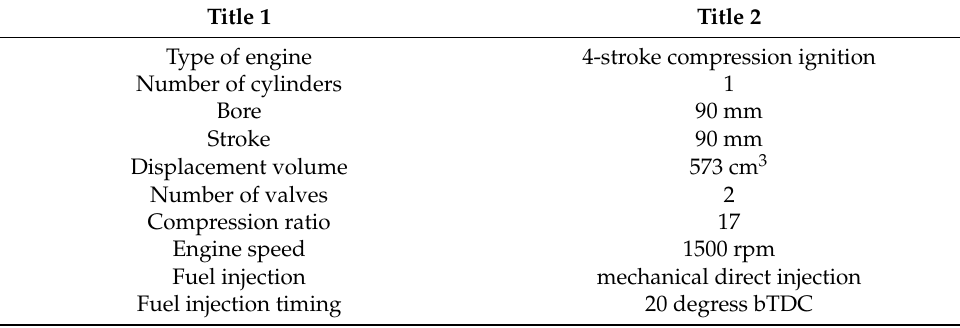
Table 1. Engine main